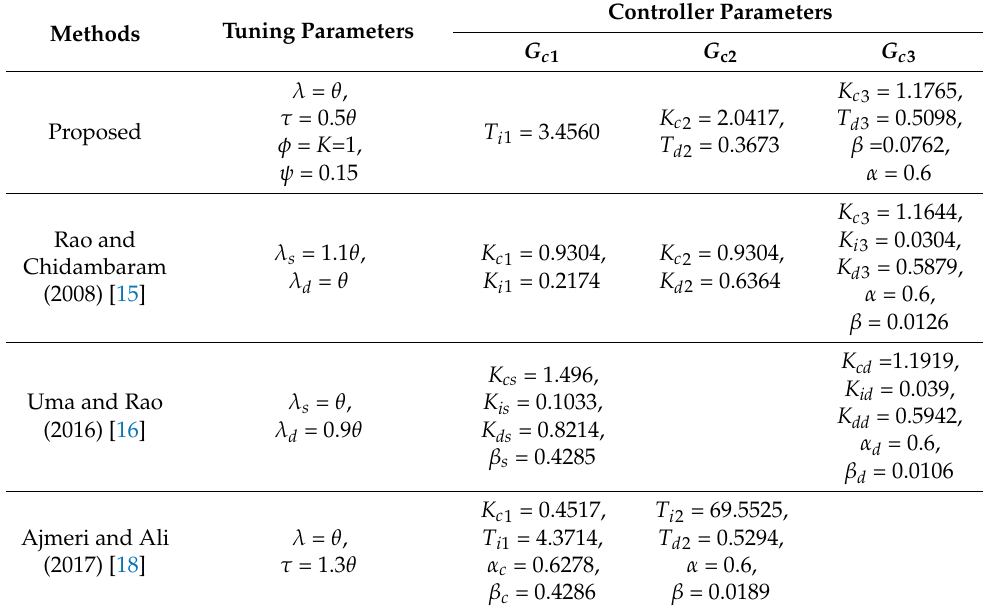
Table 4. Controller parameters for Example